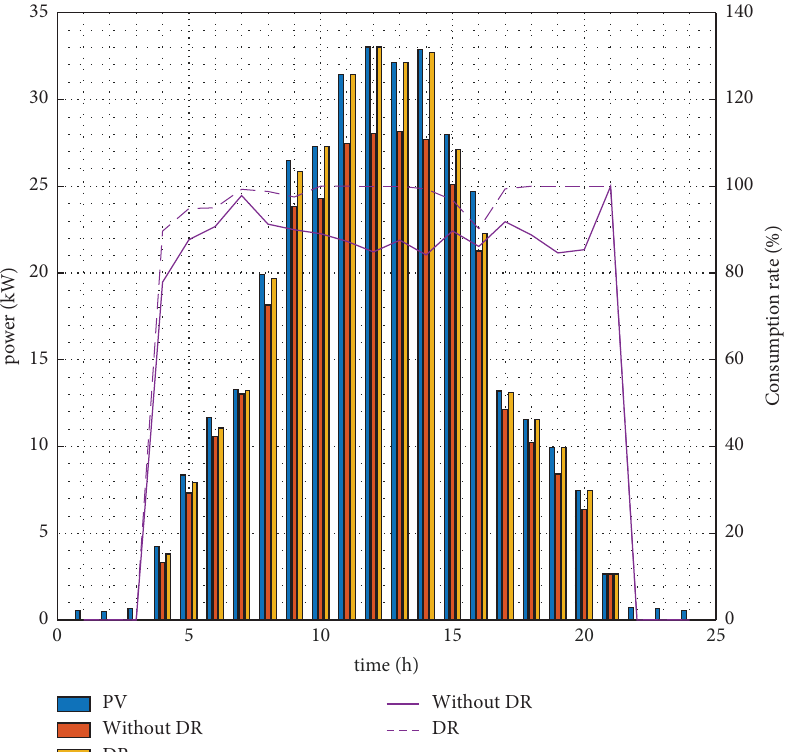
Figure 10: Comparison of photovoltaic consumption before and after